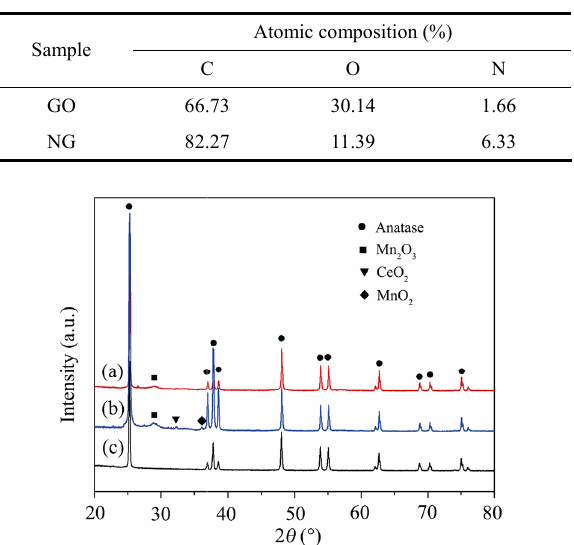
Fig. 3 XRD patterns of (a) MnO x –CeO 2 /TiO 2 –1%NG, (b) MnO x –CeO 2 /TiO 2 , and (c) TiO 2 –1%NG.